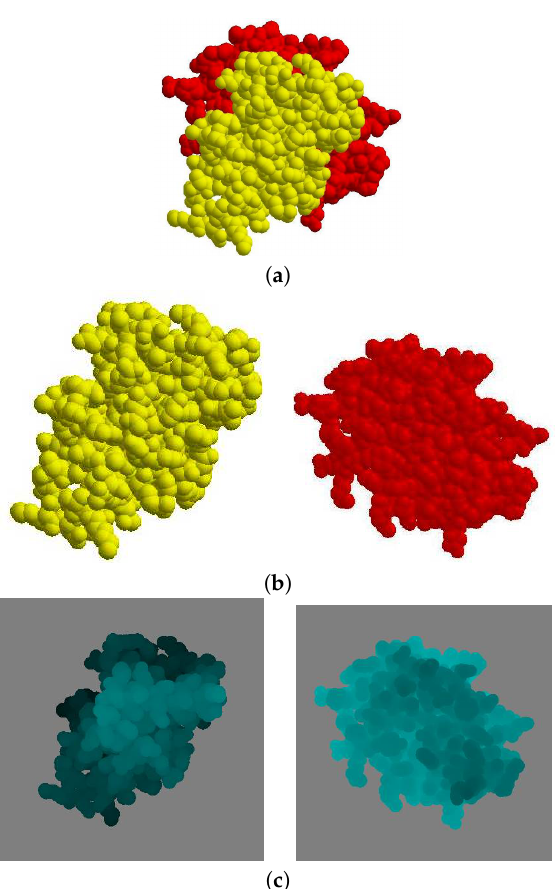
Figure 6. Depth buffer-rendered images of M A and M B in molecule (PDB id. 2HSN): ( a ) M A and M B ; ( b ) M A and M B are shown separately; and ( c ) the depth buffer images of M A and M B .